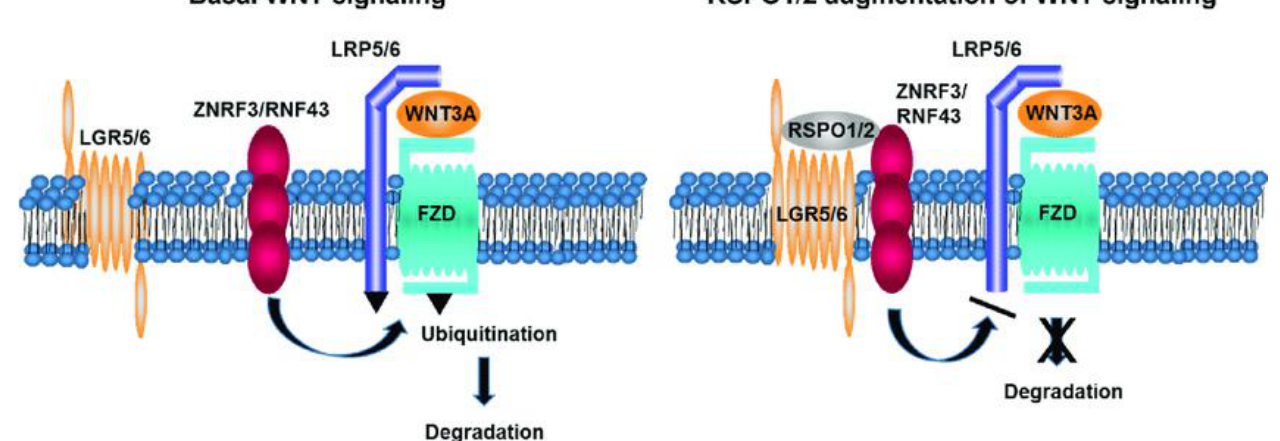
Figure 4. Wnt signalling, augmented with R-spondin. Figure replicated from [62] under Creative Commons license, provided at https://creativecommons.org/licenses/by/3.0/ (accessed on 29 Janu- ary 2023). Changes have been made to the figure legend.